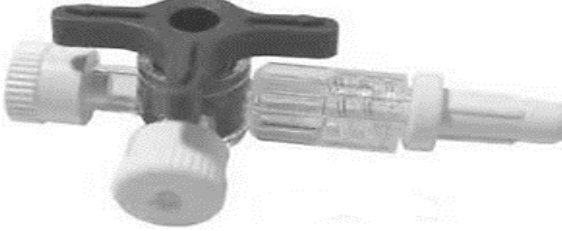
Figure 2. Three-way valve [11].